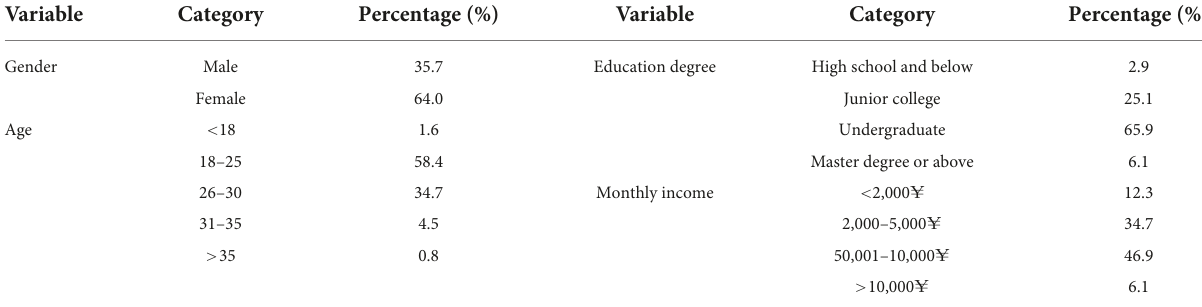
TABLE 1 Sample overview ( N =